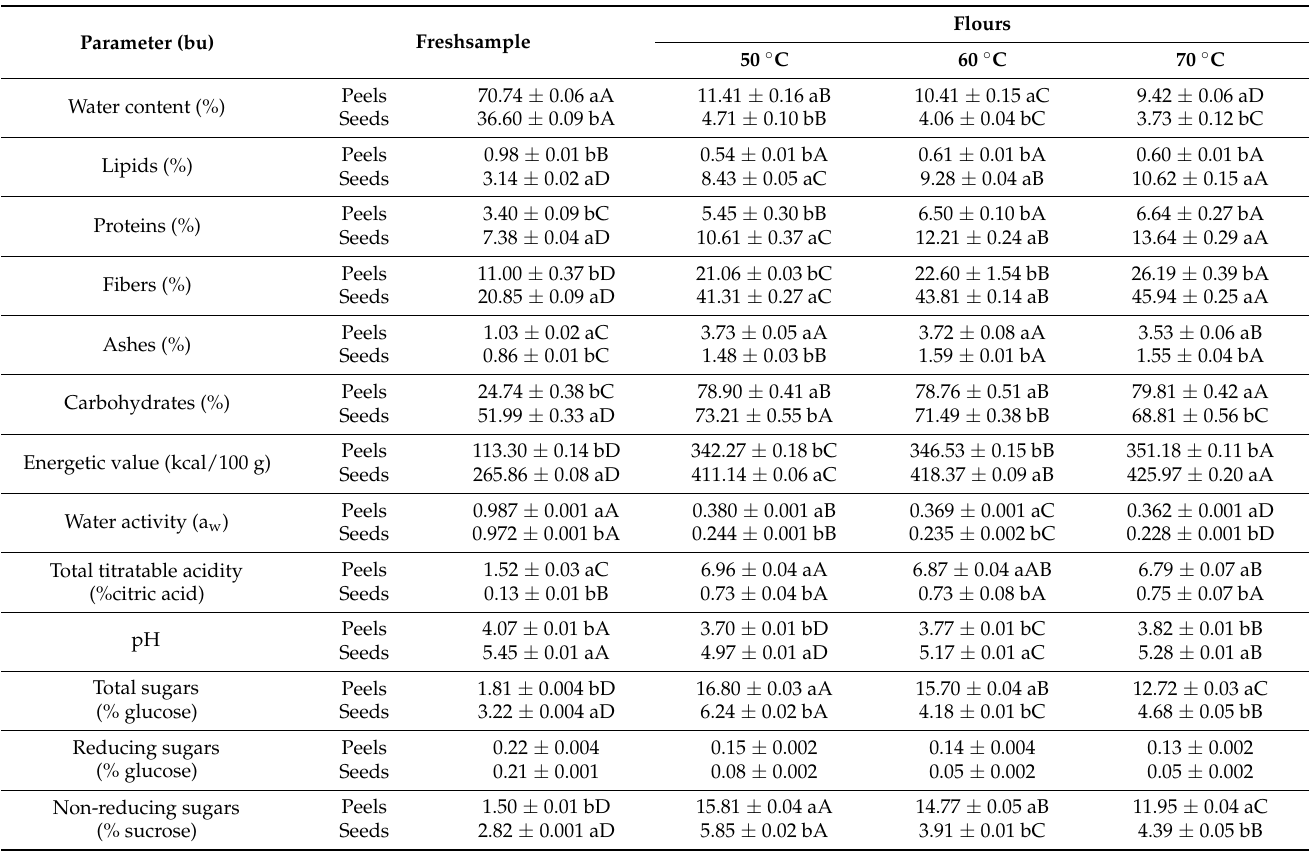
Table 8. Proximal composition and physicochemical characterization of fresh pomegranate peels and seeds and flours in wet base obtained after drying at temperatures of 50, 60, and 70 ◦